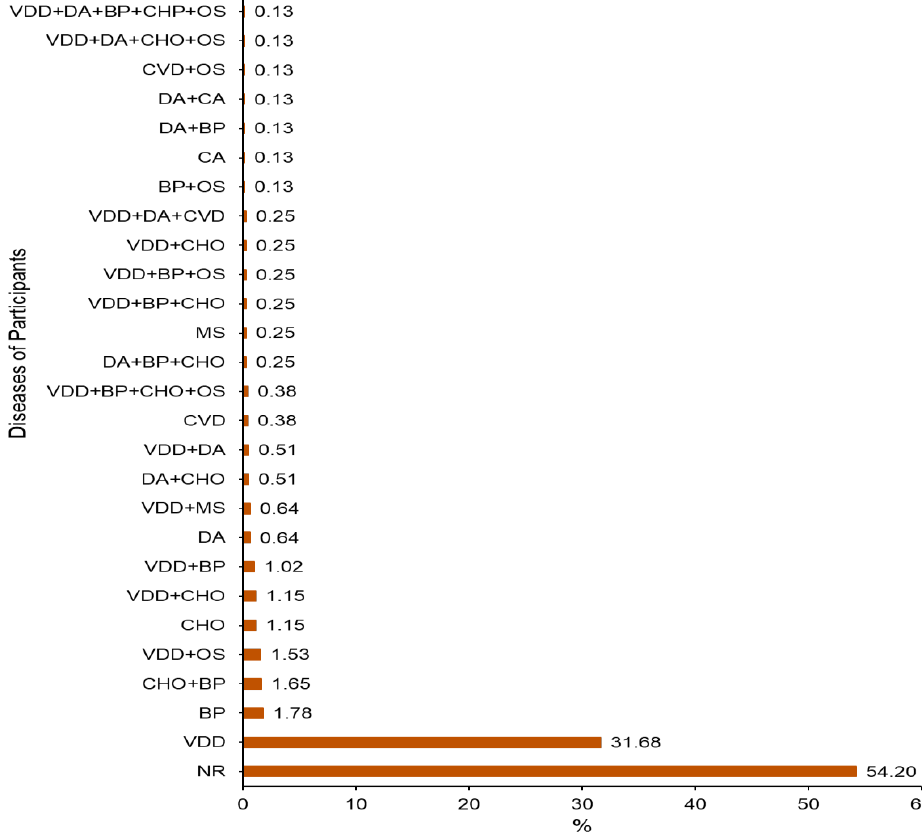
Figure 1. The medical profile of the participants, NR: Normal participants, VDD: Vitamin D deficiency, BP: Blood pressure, CHO: Cholesterol, OS: Osteoporosis, DA: Diabetes, MS: Metabolic syndrome, CVD: Cardiovascular disease, CA: